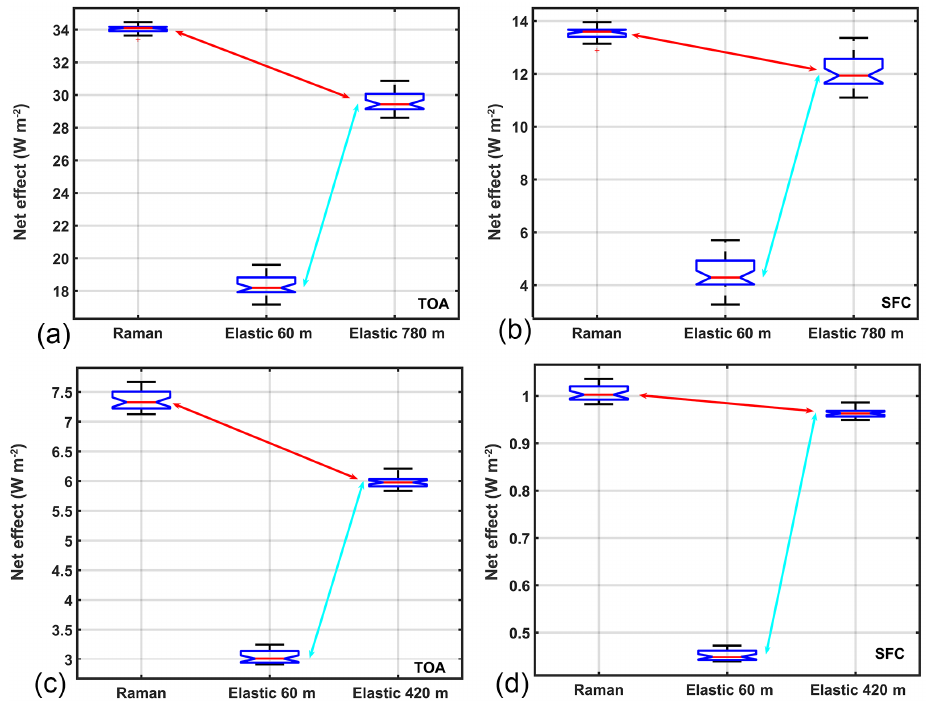
Figure 4. Same as Fig. 3 but for two cirrus cloud cases ( a, b : 17 February 2014; c, d : 10 June 2016). The Raman lidar channel is smoothed over a 420m window for cirrus on 17 February 2014 and 780m window for cirrus on 10 June 2010. The net radiative effect is calculated at TOA (a, c) and SFC (b, d) . As is clearly visible, in both cases the larger discrepancy in radiative effect is related mostly to the data processing (blue arrows), not the lidar technique (red